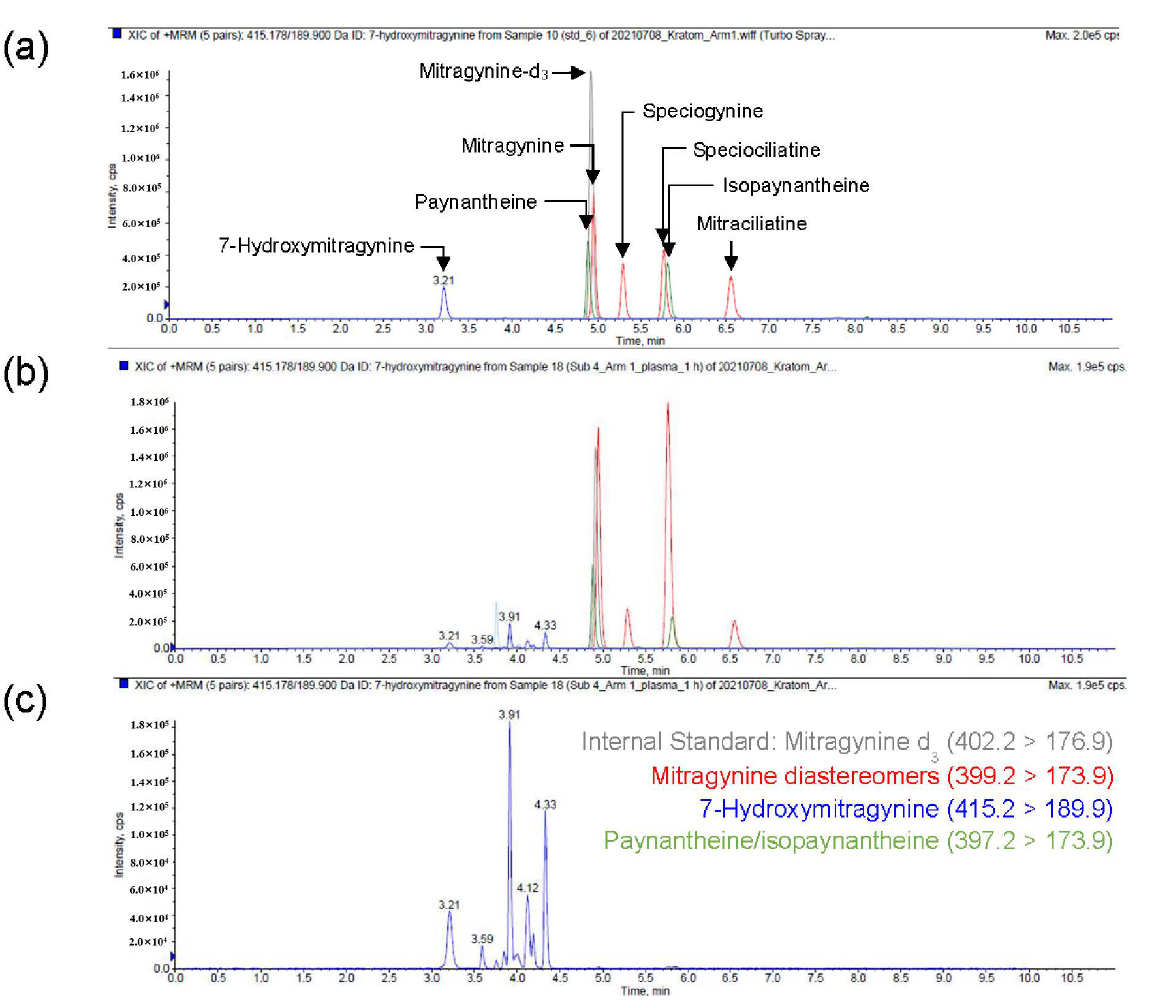
Figure 2. Representative chromatograms for simultaneous quantification of kratom alkaloids in human plasma. ( a ) Total ion chromatogram (TIC) of reference standards depicting separation of alkaloids with the same MRM transitions (diastereomers). ( b ) TIC of a representative human plasma sample 1-h post-kratom tea administration. ( c ) Extracted ion chromatogram (415 > 190)